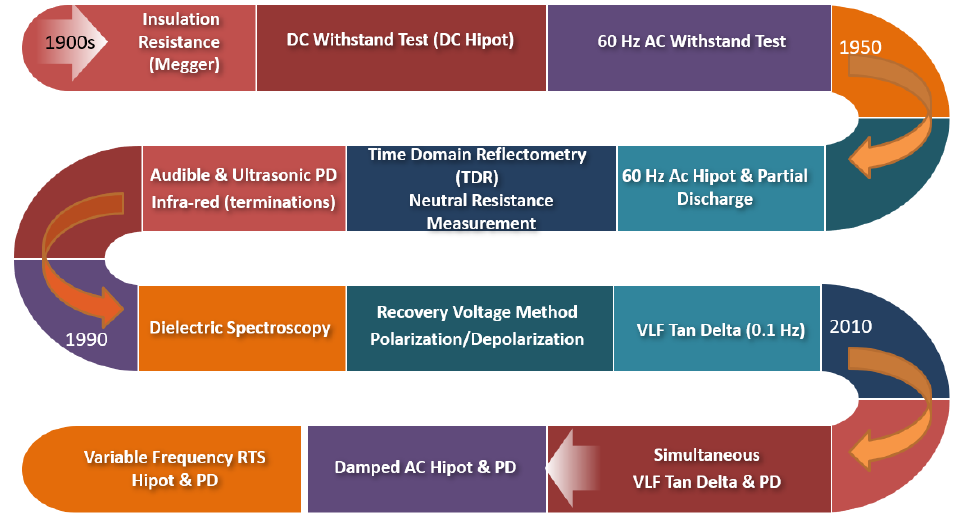
Figure 2. Evolution of testing techniques for UGPCs.